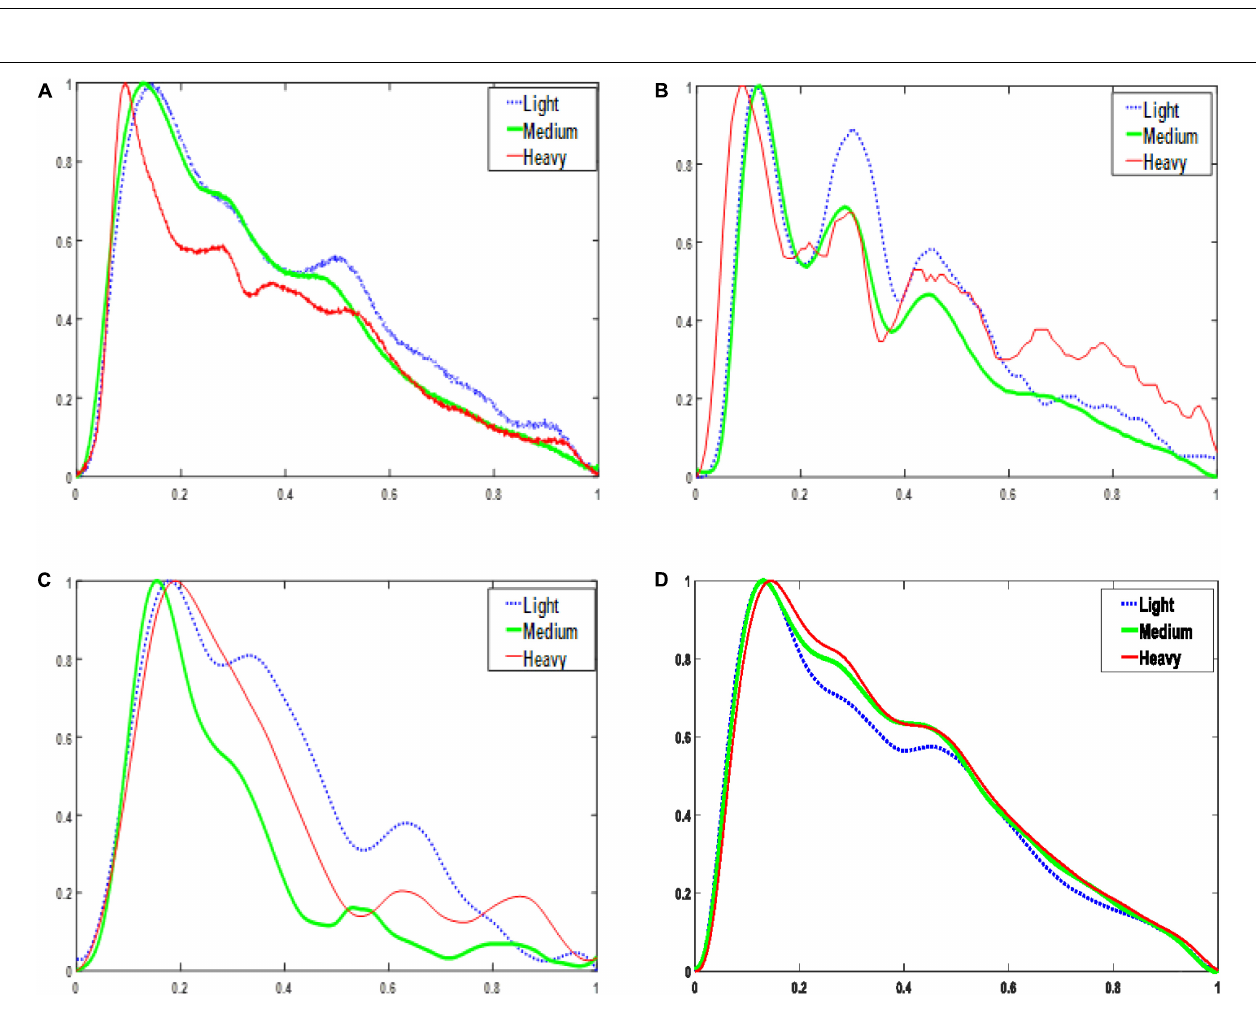
FIGURE 3 | Normalized one-period pulse waves acquired at three magnitudes of contact force. (A) PESG. (B) tonometer, (C) optical sensor, and (D) accelerometer.